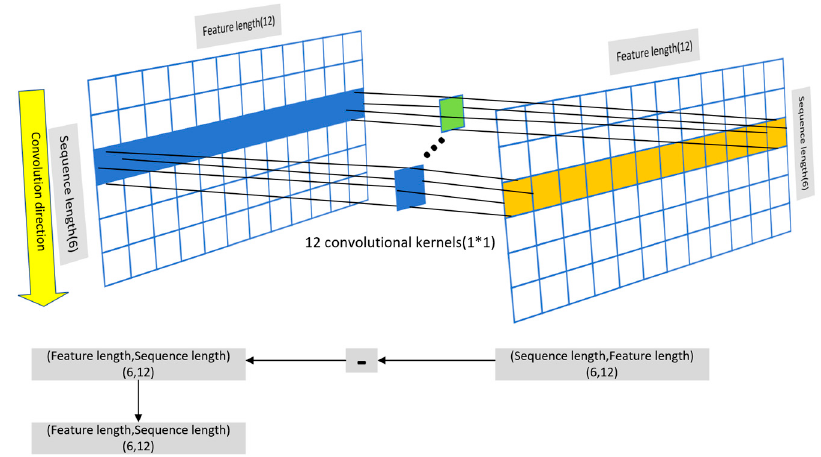
Figure 9. Time_Convolution.